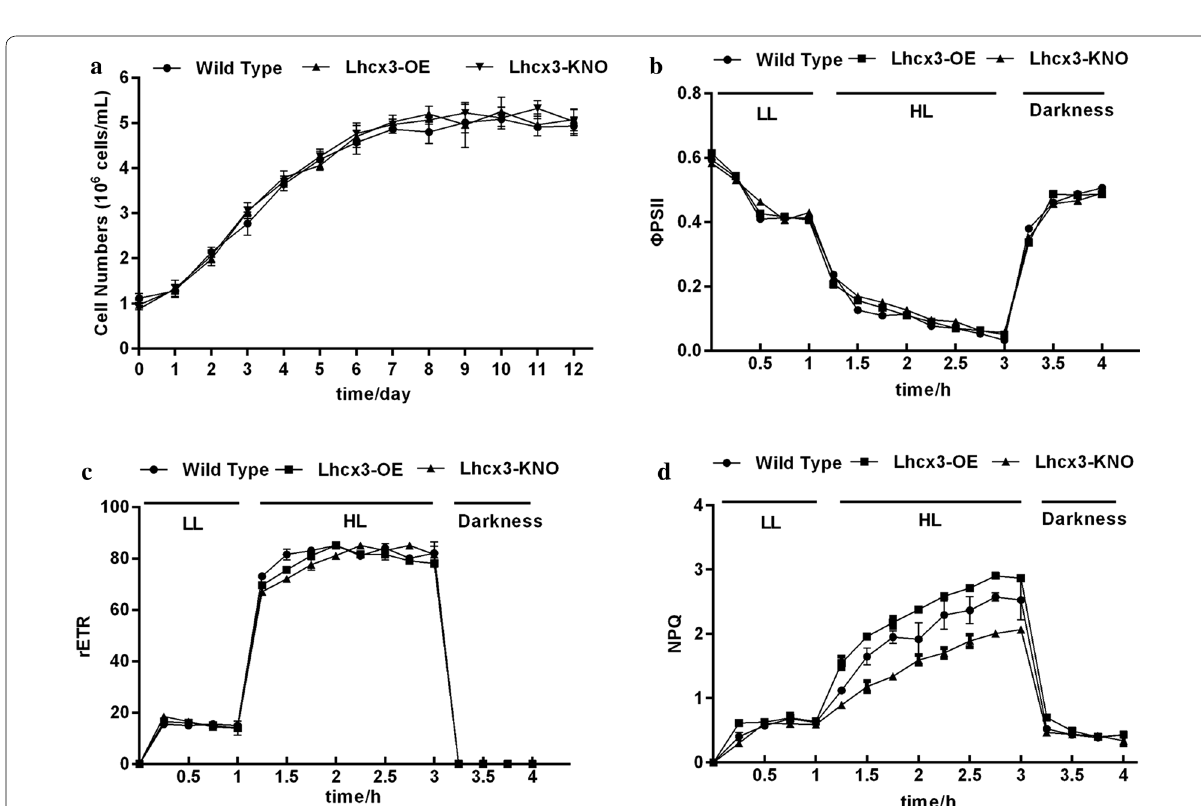
Fig. 6 Growth curves ( a ), Φ PSII ( b ), rETR ( c ) and NPQ ( d ) of transgenic lines. Significant difference between wild type and transgenic microalgae is indicated at P < 0.05 (*) or P < 0.01 (**) level. Each value represents